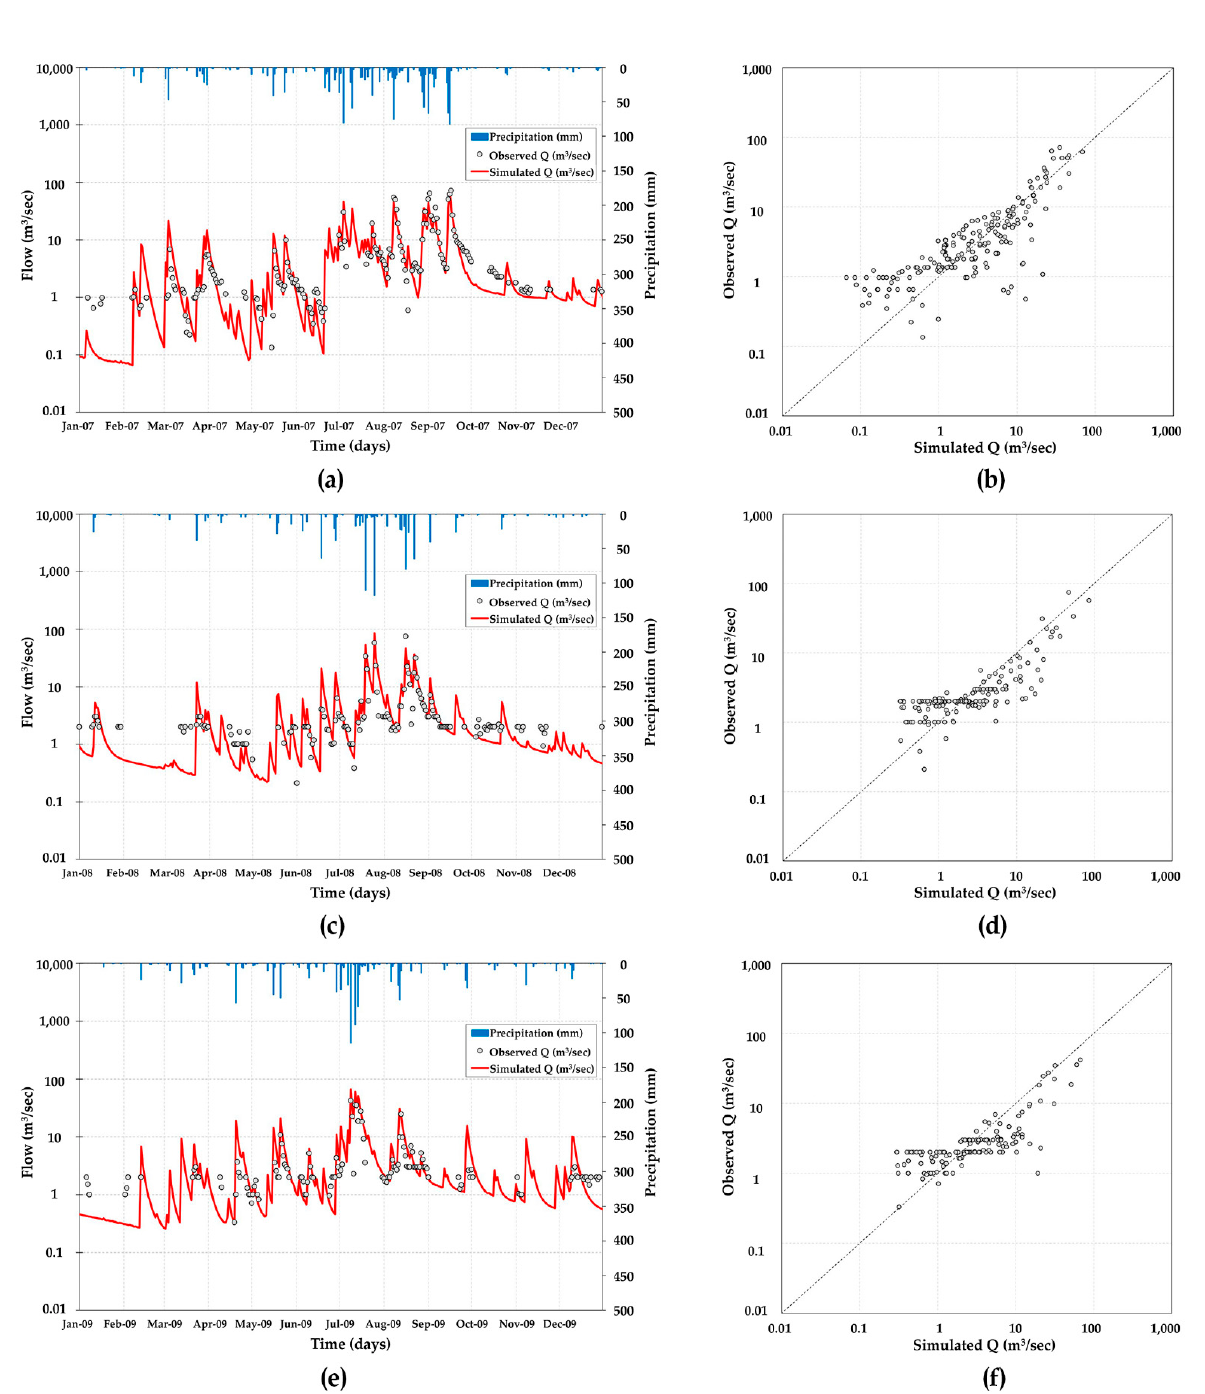
Figure 8. Soil and Water Assessment Tool calibration result (2007) and validation results (2008, 2009) of Yecheon Bridge: ( a ) calibrated hydrograph (2007); ( b ) scatterplot (2007); ( c ) validated hydrograph (2008); ( d ) scatterplot (2008); ( e ) validated hydrograph (2009); ( f ) scatterplot (2009).